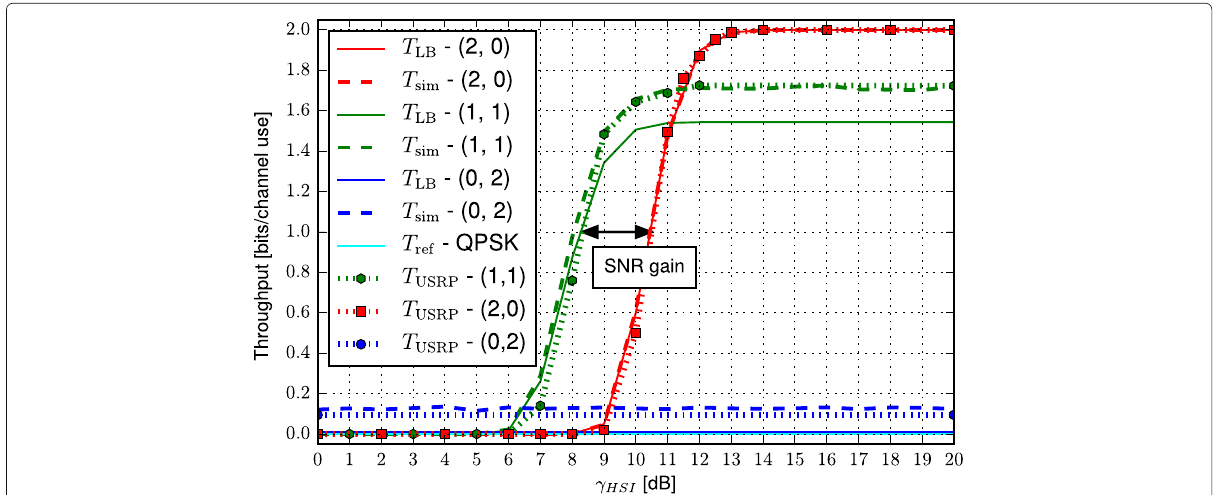
Fig. 9 Comparison of throughput as a function of γ HSI for γ MAC = 20dB, γ BC = 16dB and given ( N b , N s